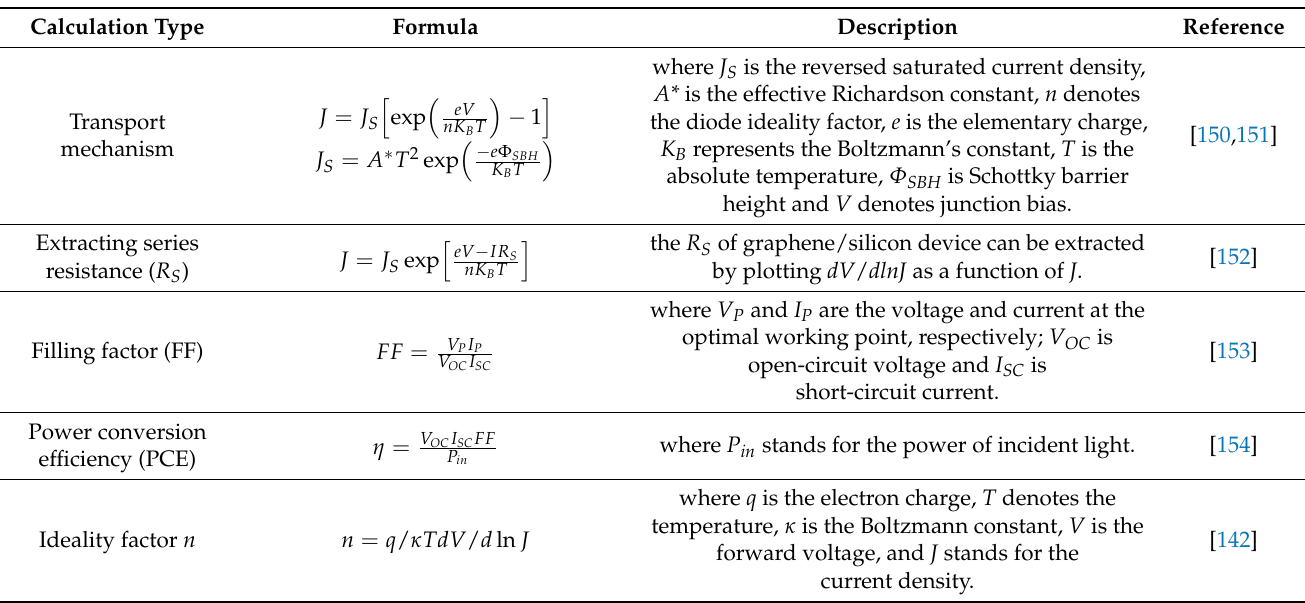
Table 4. Rules held for the Schottky solar